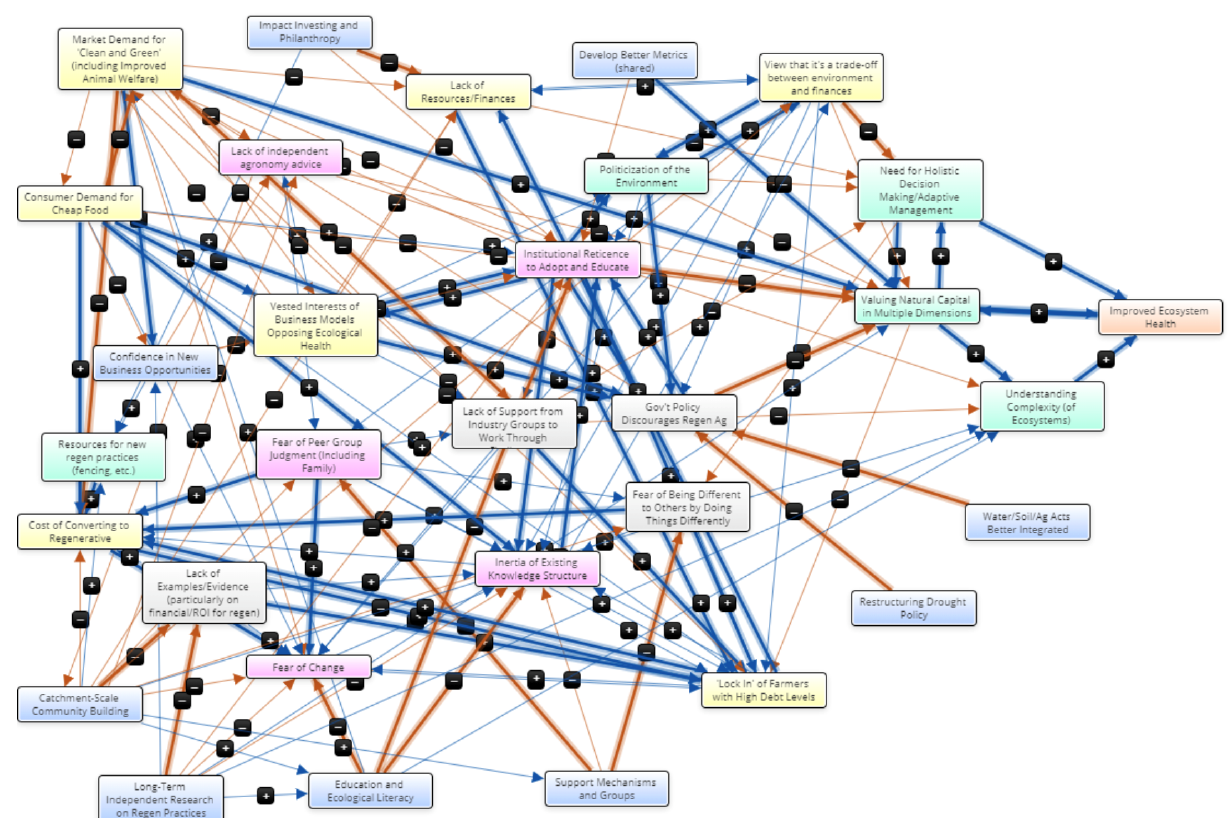
Figure 4. The combined FCM elicited from workshop participants. We used different colors to reflect the different variable categories, similar to what we had used in MURAL (green = environmental, yellow = financial/economic, gray = social, and pink = behavioral), while our ‘levers’ or actions we could take were in blue. Our metric, ‘ Improved Ecosystem Health ’ in orange, was the measure we sought to influence and understand, as a broader proxy for the success of RegenAg. Arrows indicate causal relationships. The color of the arrows indicated their polarity (red arrows were negative or ‘balancing’ relationships, and blue arrows were positive or ‘reinforcing’ relationships), and the width of the arrow indicated the strength of the relationship (thick were ‘strong’ relationships, thin were ‘weak’